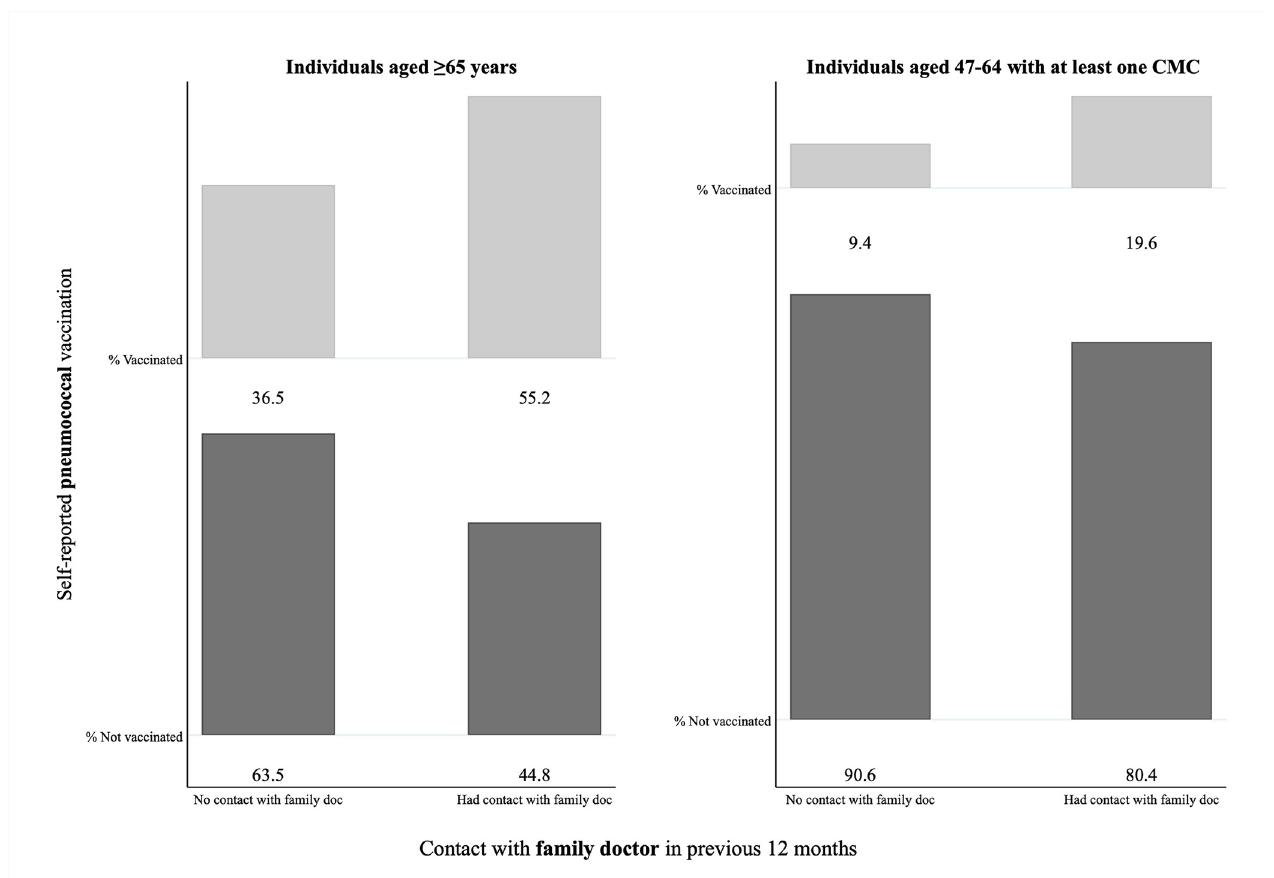
Fig 4. Self-reported pneumococcal vaccination status among CLSA participants aged � 65 years (n = 22,234) and among those aged 47–64 with at least one chronic medical condition (CMC) (n = 10,807), stratified by history of contact with a family doctor in the previous 12 months. Percentages of individuals who were vaccinated or non-vaccinated against pneumococcal disease are shown for each category. For each of the two groups eligible for pneumococcal vaccination, those with no available data concerning prior contact with a family doctor were excluded (i.e., 12 and 8, respectively).